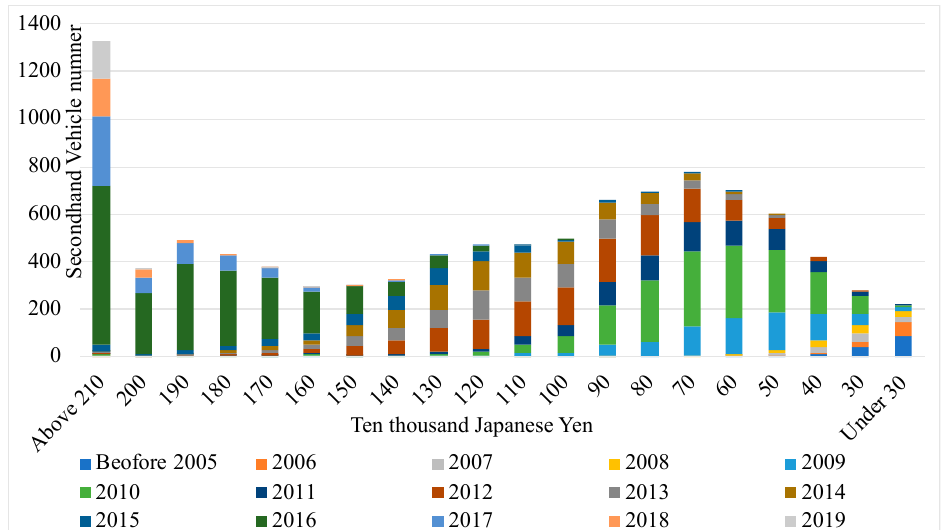
Figure 4. Price of secondhand HV (Prius) of each age in Japan. Source: Figure made by the author based on Carsensor’s data [22].